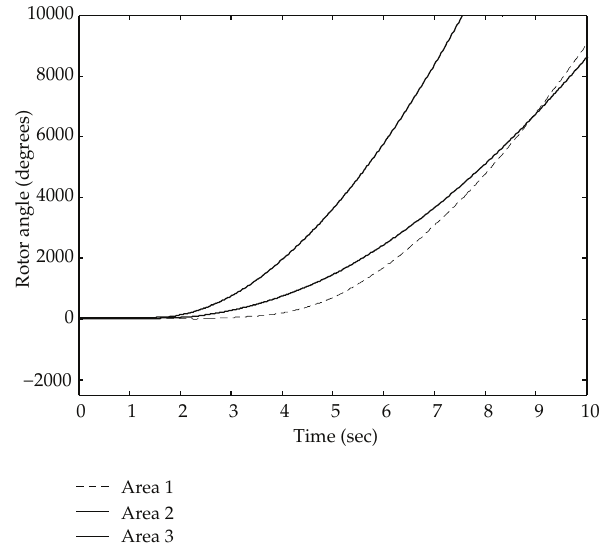
Figure 12: Case 2: the system becomes unstable due to the fault at Line 18.